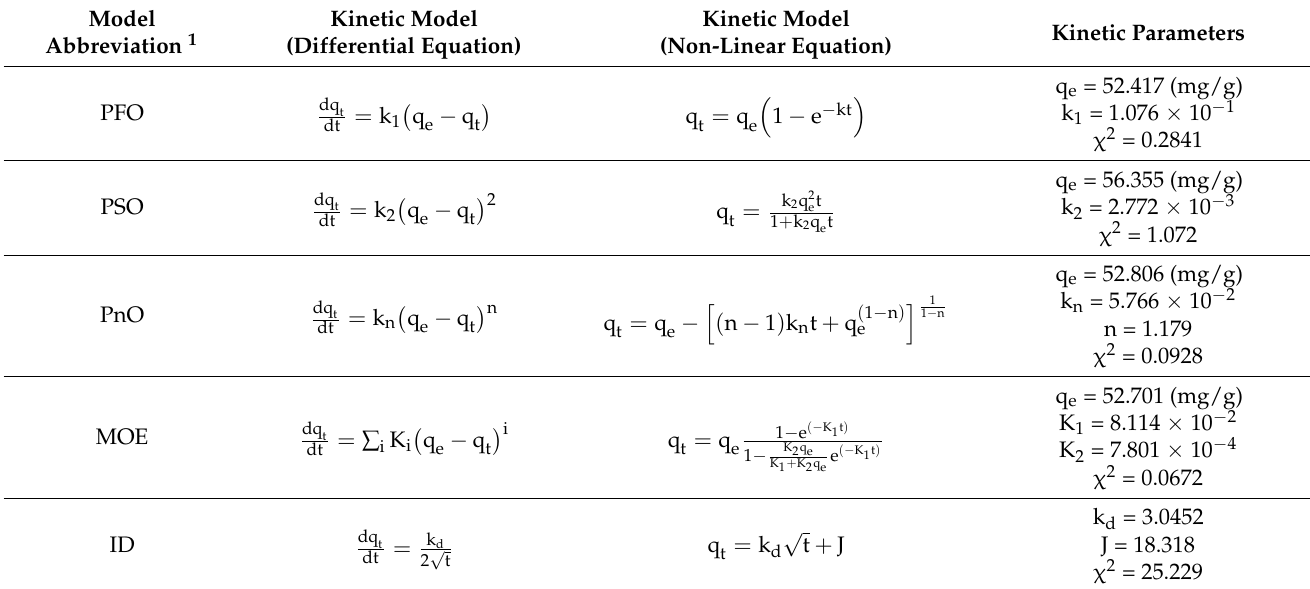
Table 1. Kinetic models and parameters for MB dye adsorption onto SPEEK beads,